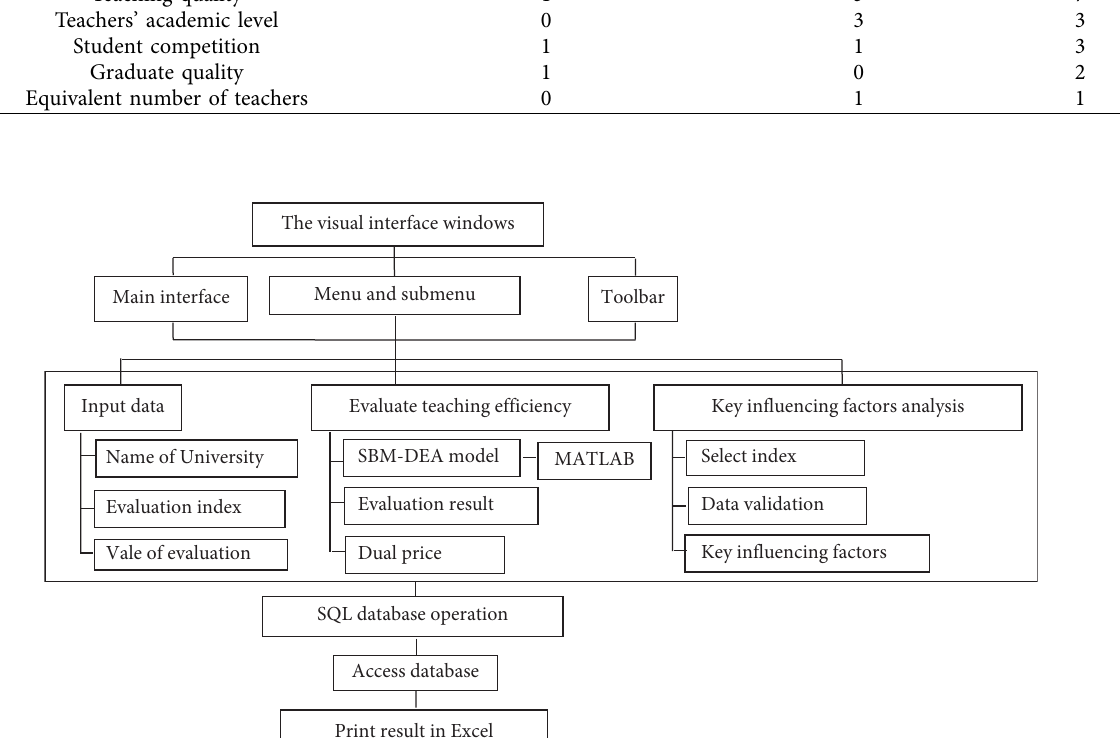
Figure 1: Framework and function design of the visual decision analysis